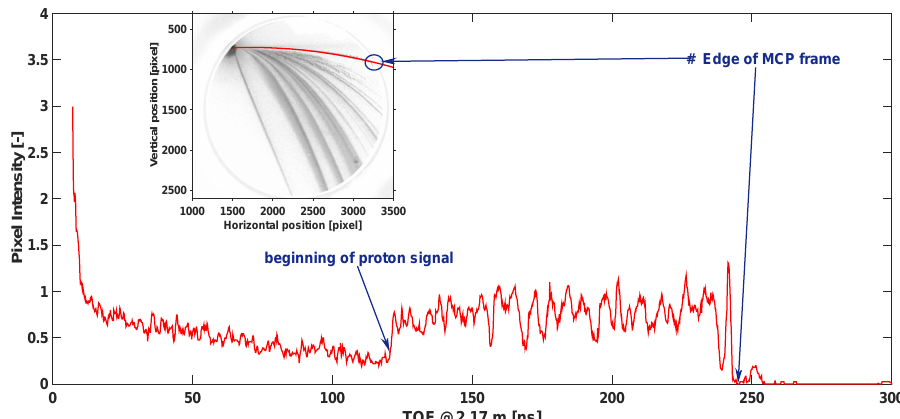
Figure 3. Intensity of pixels along the parabolic track of protons as a function of time of flight (TOF) derived from the velocity corresponding to each point of the parabolic curve. Subplot shows the TP snapshot in grayscale with the parabolic curve used for reading pixel intensity. The edge of the MCP screen is clearly visible. The TOF corresponding to the edge was taken as a point where the EMP no longer influenced the proton trajectories.